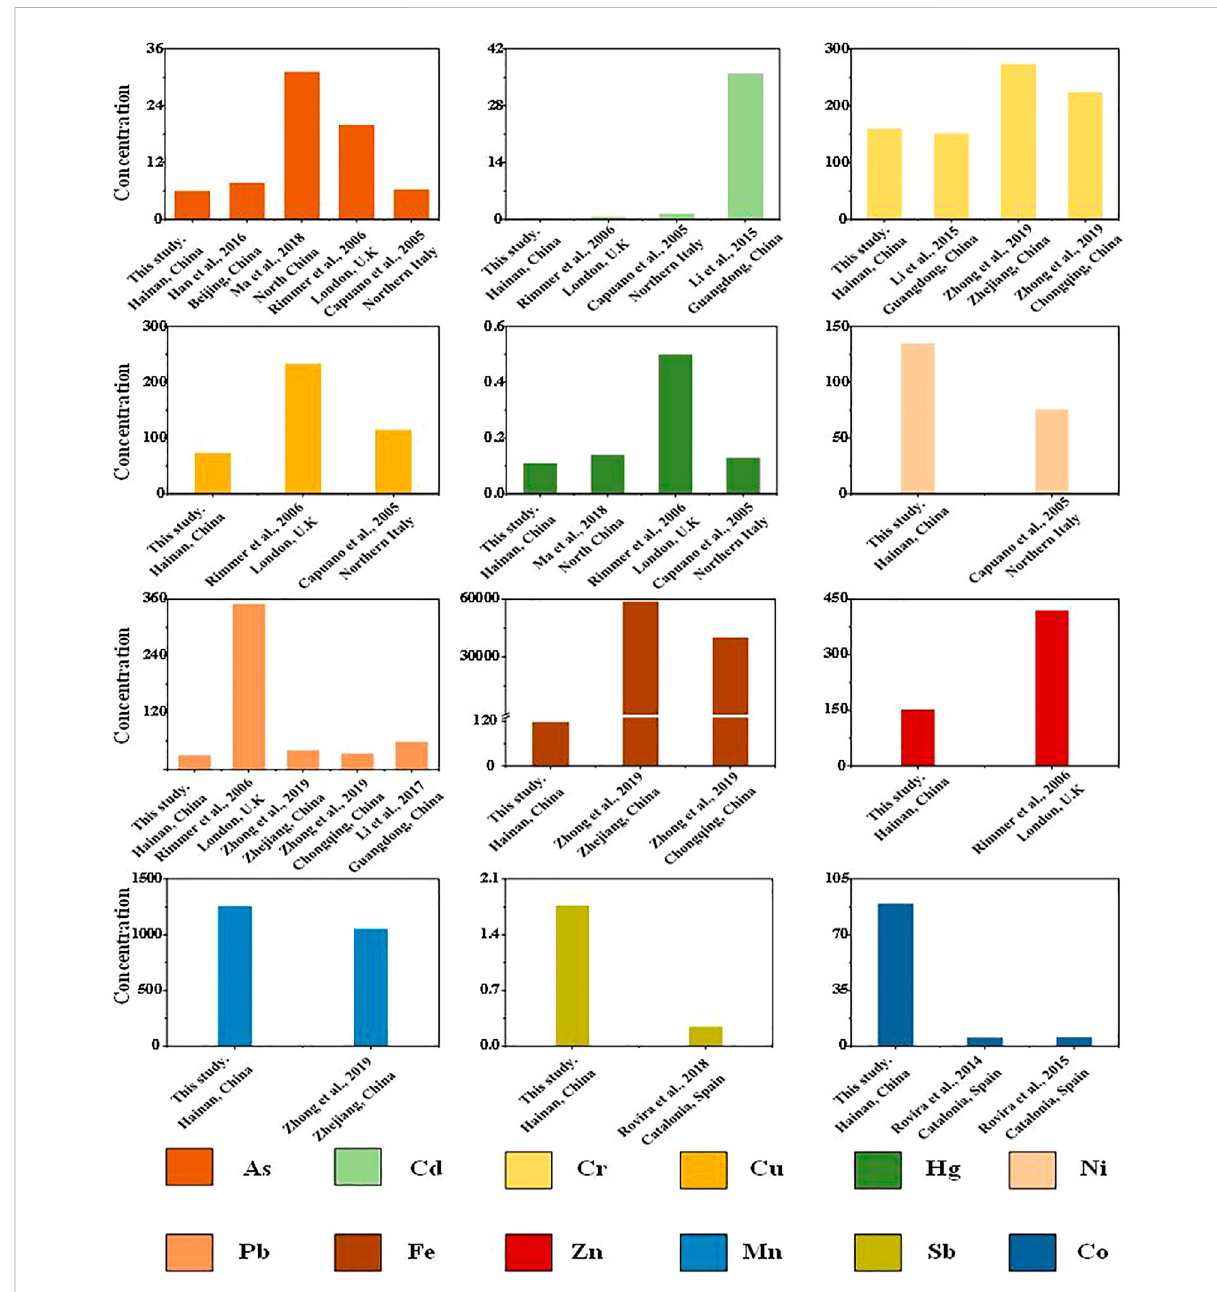
FIGURE 5 Comparative analysis of the literature on concentrations (Fe, unit: g · kg − 1 ; others, unit: mg · kg − 1 ) of metals from MSW incineration.